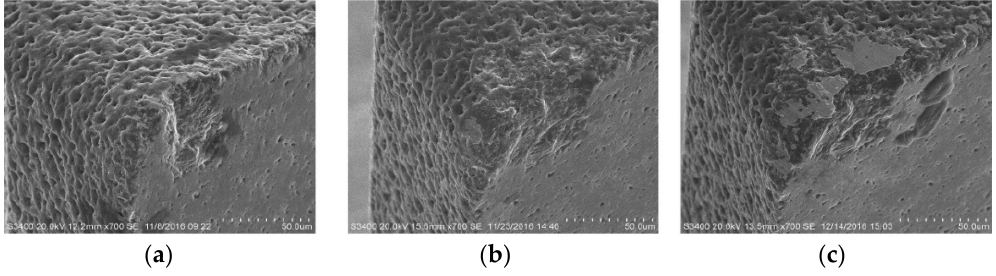
Figure 12. The effect of material removal volume on tool wear morphology. ( a ) V = 0.4 mm 3 ; ( b ) V = 1.6 mm 3 ; ( c ) V = 3.2 mm 3 . ( b ) V = 1.6 mm 3 ; ( c ) V = 3.2 mm 3